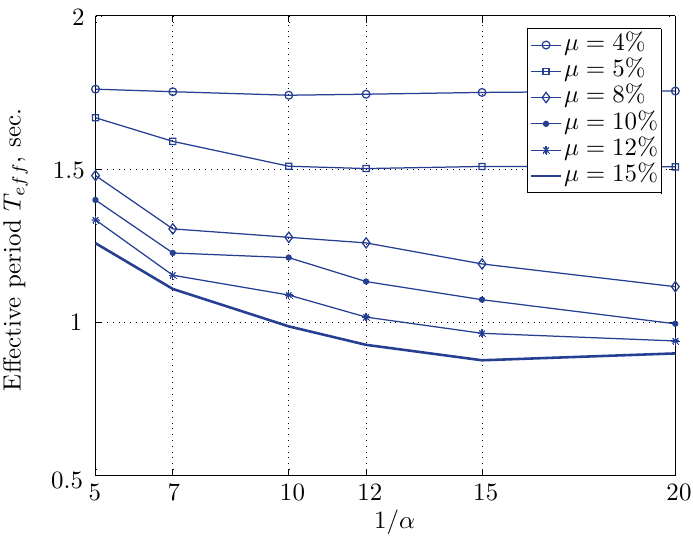
Figure 29. Effective period for various isolation system parameters (Lucerne).